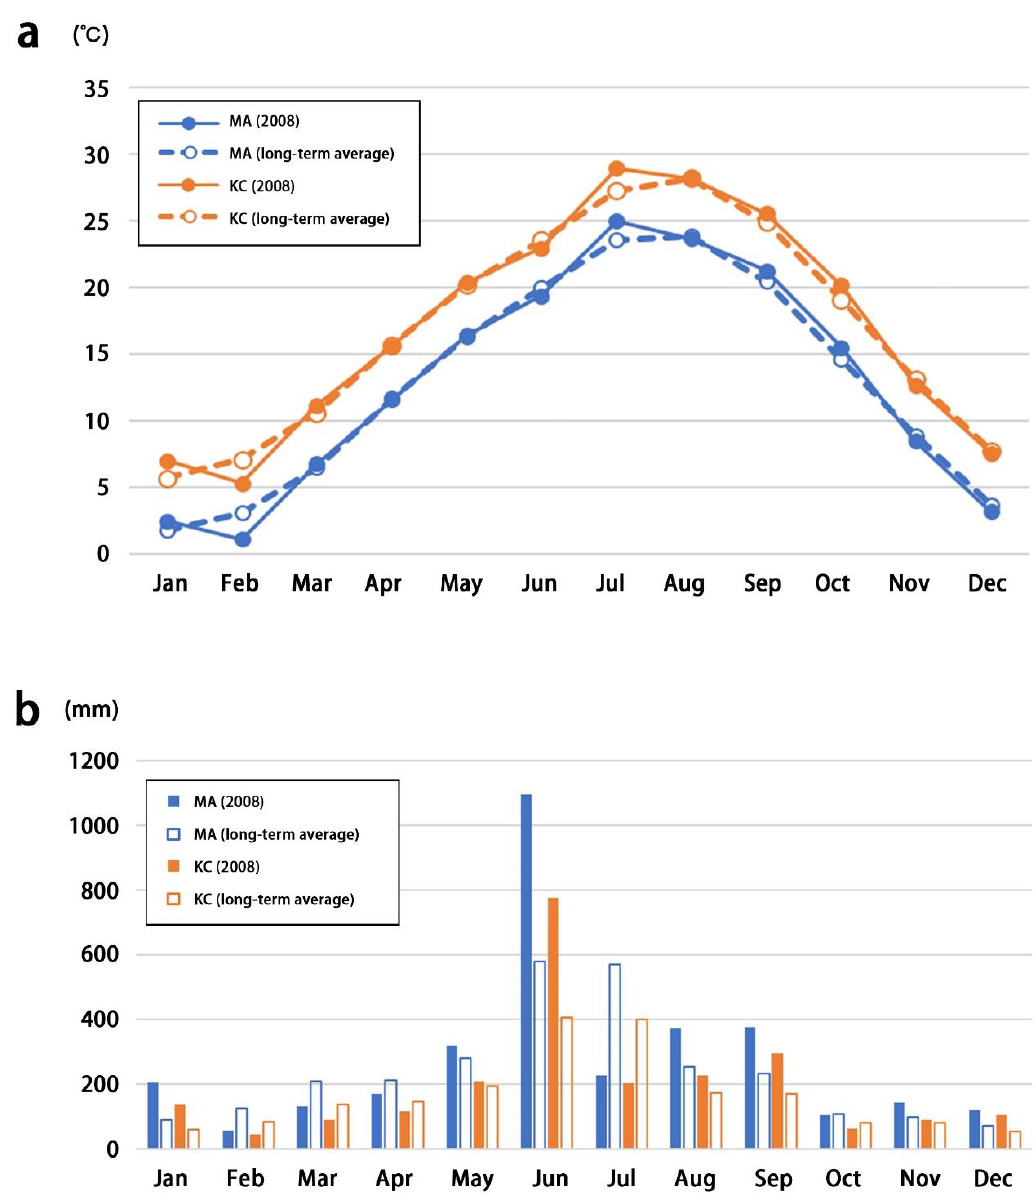
Figure 2. Progress of (a) monthly mean air temperature in 2008 (solid line with solid circles) and long-term average monthly air temperature (dotted line with open circles), and (b) monthly total precipitation in 2008 (shaded column) and long-term average monthly total precipitation (unshaded column) at the MA (Mount Aso, blue) and KC (Kumamoto City, red) experimental sites. The reference period for the long-term averages is 1981‒2010. Source: weather service of Japan Meteorological